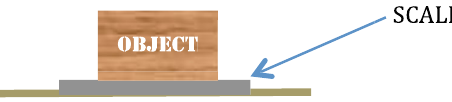
FIG. 5. An object on a scale on the